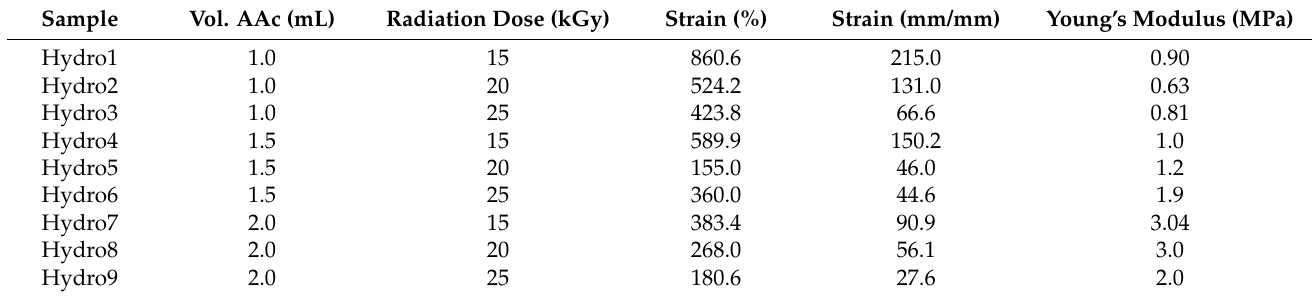
Table 1. Mechanical properties of hydrogels synthesized at different doses and monomer concentrations.